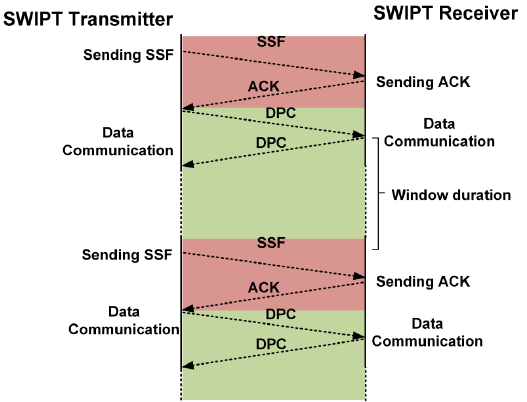
Figure 12. Exchange of the data frames for window duration after synchronization.